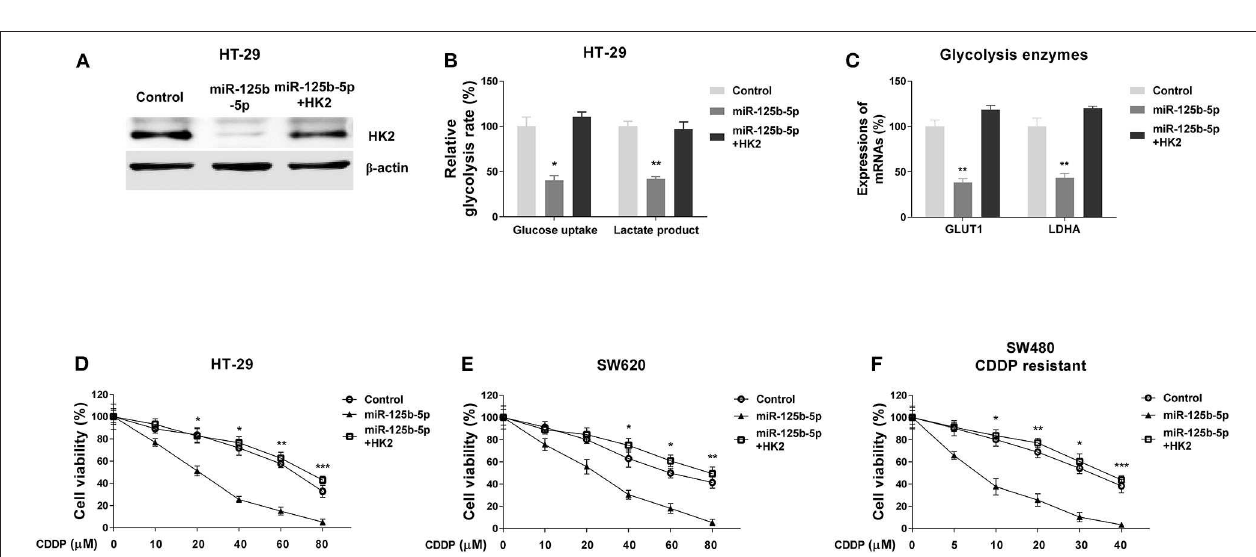
FIGURE 6 | Restoration of HK2 in miR-125b-5p–overexpressing cells recovers glycolysis and cisplatin resistance. (A) HT-29 cells were transfected with control miR, miR-125b-5p alone, or miR-125b-5p plus HK2; the expressions of HK2 were measured by Western blot. β -Actin was an internal control. (B) The glucose uptake and lactate product assays were performed from the above cells. (C) The mRNA expressions of GLUT1 and LDHA were measured from the above cells. (D) HT-29, (E) SW620, and (F) SW480/CDDP R cells were transfected with control miR, miR-125b-5p alone, or miR-125b-5p plus HK2; cells were treated with cisplatin at the indicated concentrations. Cell viability was measured by MTT assay. Data are presented as mean ± SD. * p < 0.05, ** p < 0.01, and *** p < 0.001. and LDHA, other glycolysis key enzymes to normal levels cotransfection of miR-125b-5p and HK2 successfully restored ( Figure 6C ). We further assessed whether HK2 recovery could the miR-125b-5p–suppressed glucose uptake and lactate product desensitize the miR-125b-5p–overexpressing colon cancer cells ( Figure 6B ). Expectedly, HT-29 cells with HK2 restoration to cisplatin. Subsequently, HT-29 and SW620 cells without or showed significantly increased mRNA expressions of GLUT1